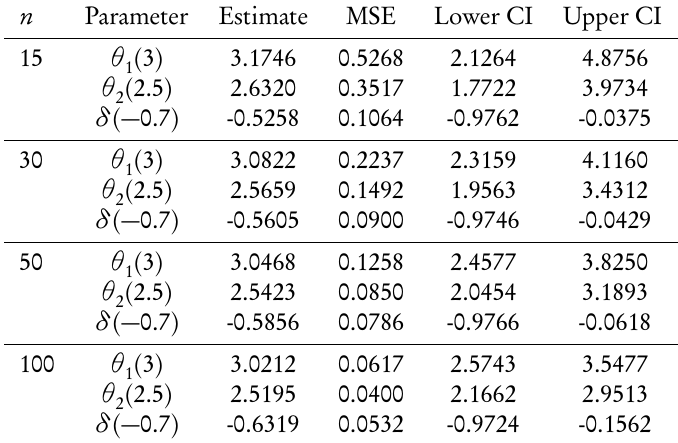
Simulation study of the parameters of BXG distribution (Case 4 - IFM).